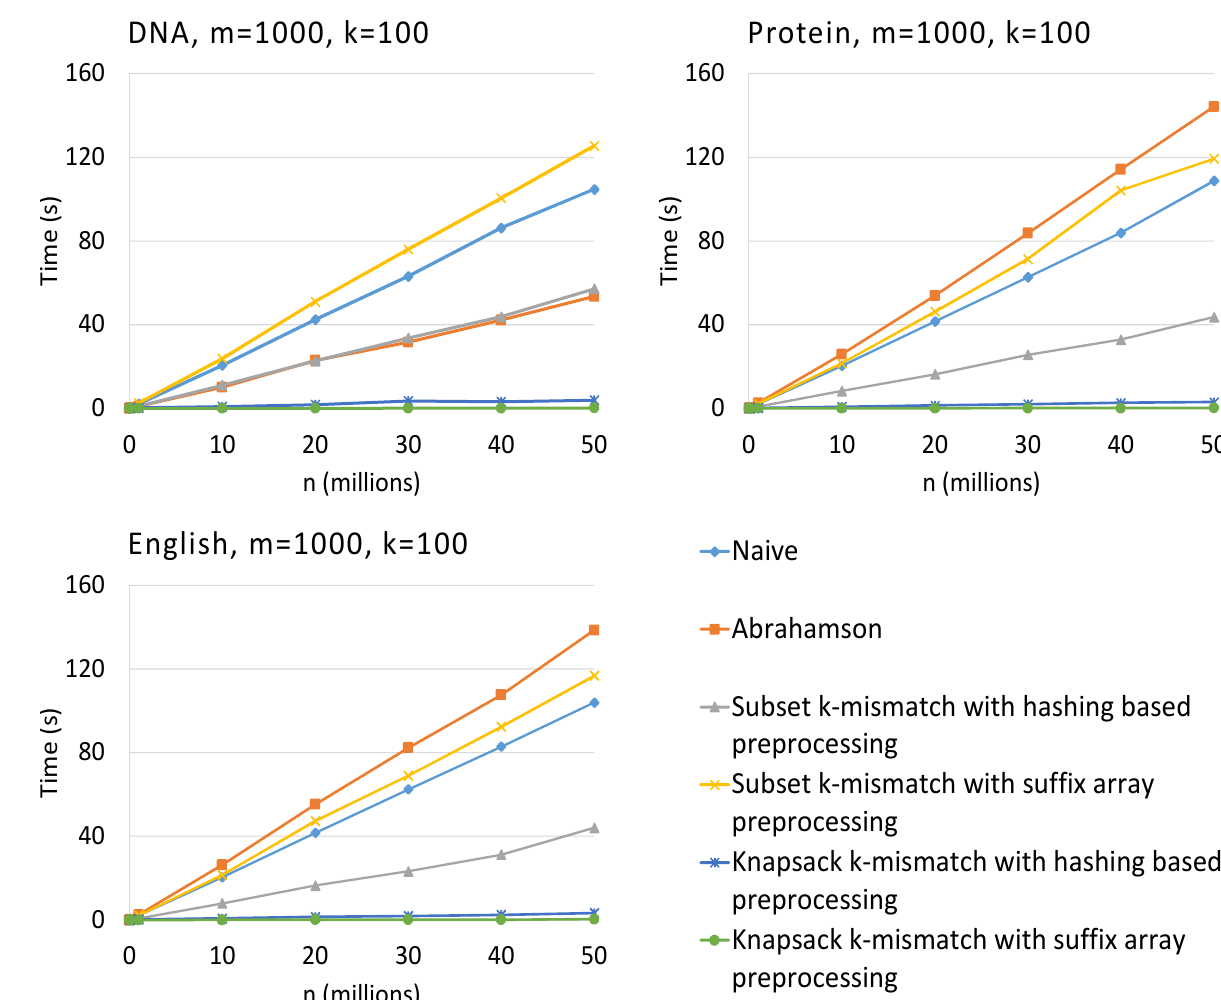
Figure 1. Run times for pattern matching on DNA, protein and English alphabet data, when the length of the text ( n ) varies. The length of the pattern is m = 1000